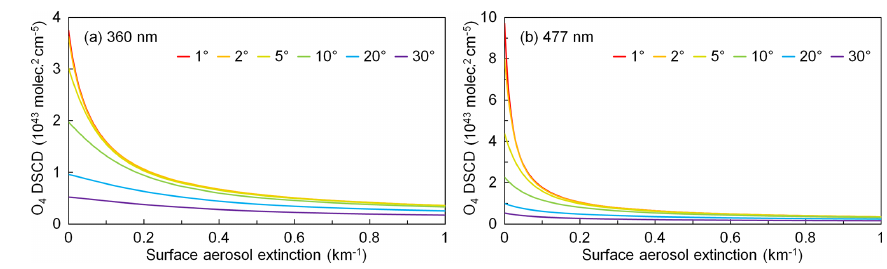
Figure B6. Seasonal average aerosol extinction profiles extracted from ceilometer